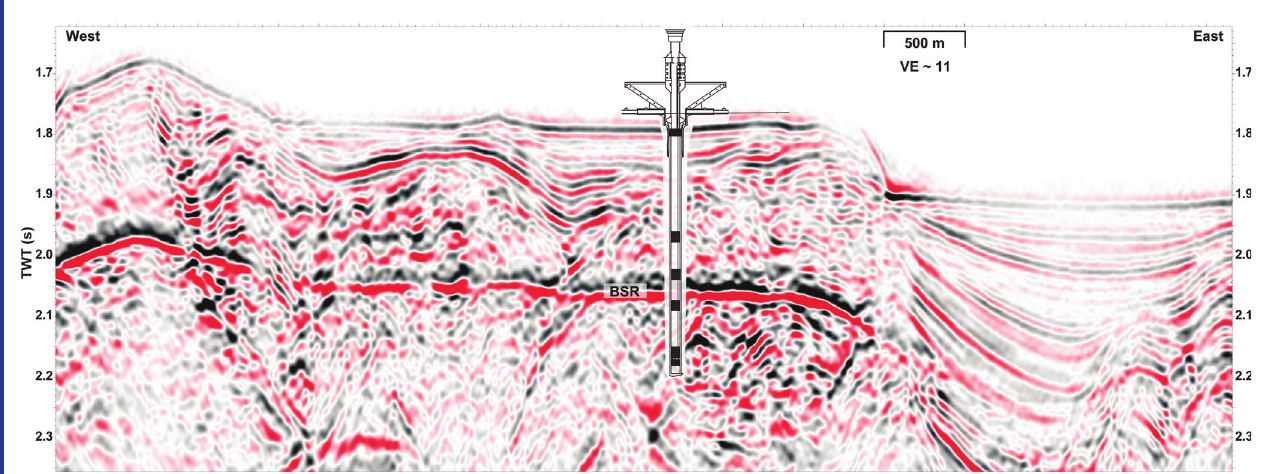
Figure 2. Seismic reflection profile crossing Hole U1364A, showing gently deformed slope basin sediments, strongly deformed accretionary prism sediments, and a bottom-simulating reflector (BSR) marking the boundary between hydrate-bearing sediments above and gas-bearing pore water below. Position of the ACORK with its monitoring screens is indicated. Profile location is shown in Fig.